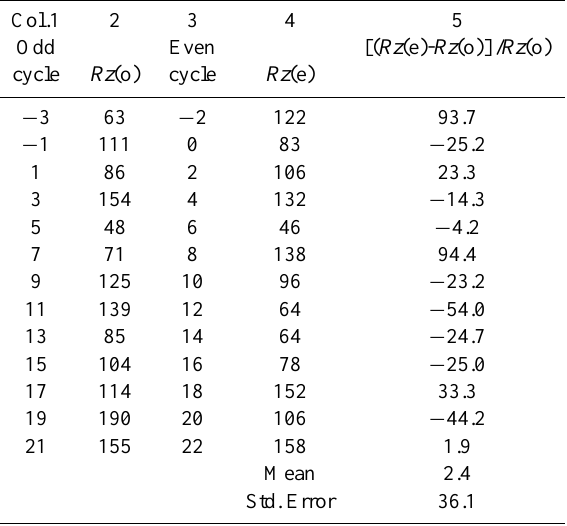
Table 3. The G-O effect for odd-even pairs. Successive odd(o)- even(e) cycles (colums 1 and 3) and their Rz (o) and Rz (e) values (colums 2 and 4) are given and the percentage excess of the value of the odd cycle over the value of the preceding even cycle [( Rz (o)– Rz (e))/ Rz (e)] is indicated (fifth